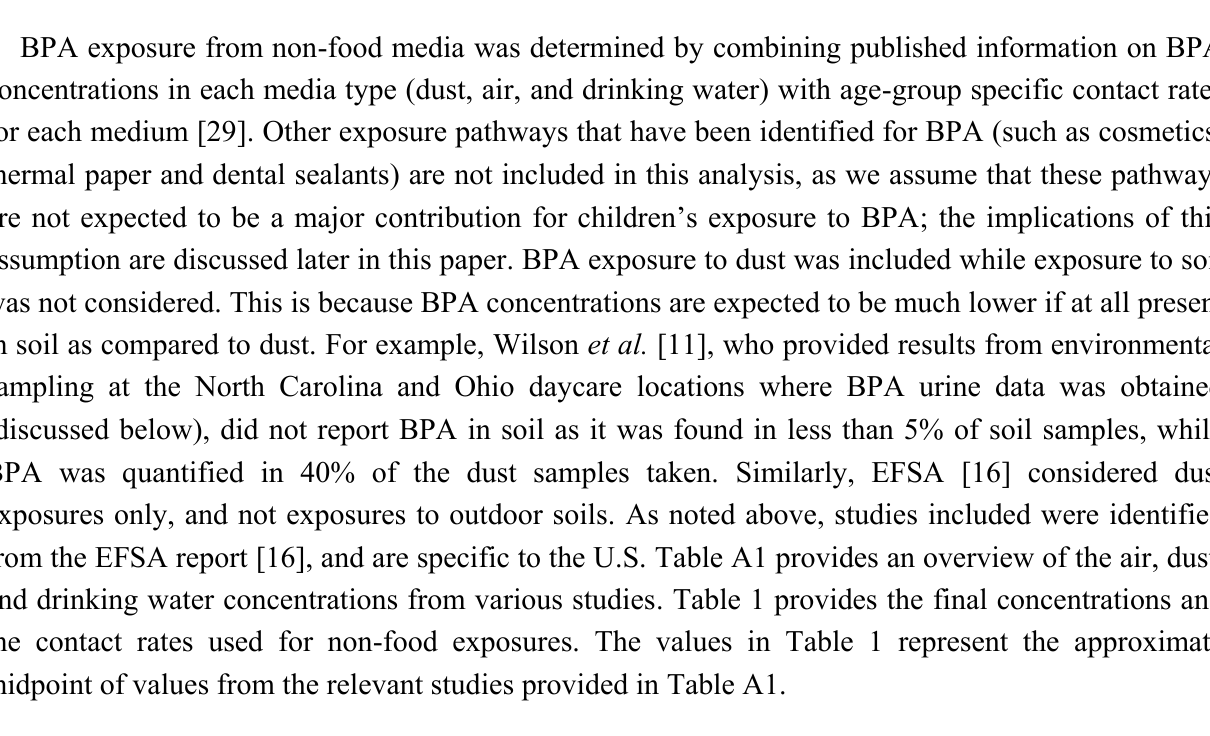
Table 1. Intake equation and parameters for non-food media, with media contact rates by age